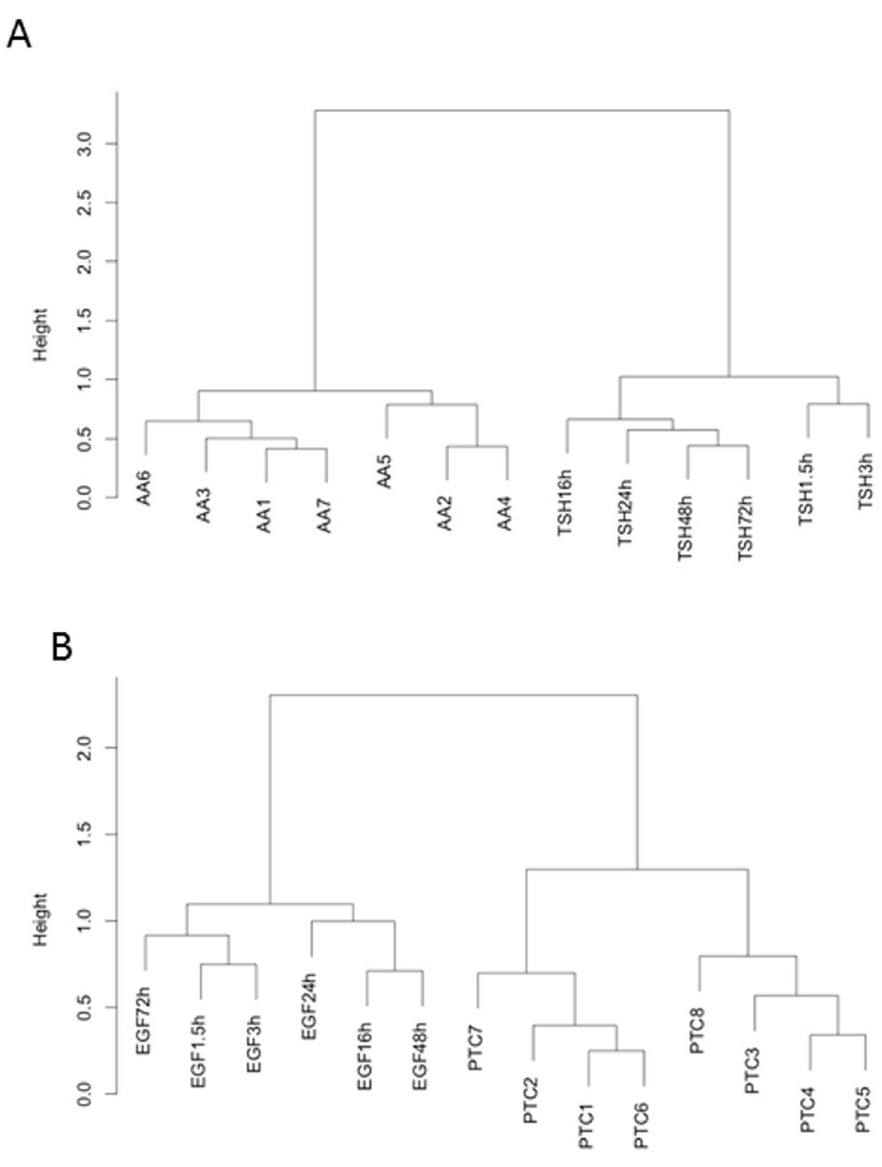
Figure 2. Hierarchical clustering on the miRNA expression data from primary cultures treated with TSH or with EGF/serum and from tumor tissues. Hierarchical clusterings were generated using R 2.8.1. The method used to compute the distance was ‘‘Ward’’. A. Hierarchical clustering on the data from the primary cultured thyrocytes stimulated with 0.3 mU/ml of TSH for 1.5, 3, 16, 24, 48 and 72 hours and from 7 autonomous hyperfunctioning adenomas (AA). A time evolution in miRNA expression according to TSH treatment of primary cultured thyrocytes is observed suggesting fine changes in miRNA level. The AA cluster apart from the TSH treated primary cultures indicating a clear separation between those two groups of samples. Each time point is the mean of triplicates. B. Hierarchical clustering on the data from primary cultured thyrocytes stimulated with 25 ng/ml EGF and 10% serum for 1.5, 3, 16, 24, 48 and 72 hours and from 8 papillary thyroid carcinomas. In this case, no temporal evolution could be observed by hierarchical clustering. Each time point is the mean of triplicates. Tumors and treated primary cultures clustered apart, suggesting that primary cultures evolved differently according to the treatment but that there was no convergence to AA or PTC for the long- term